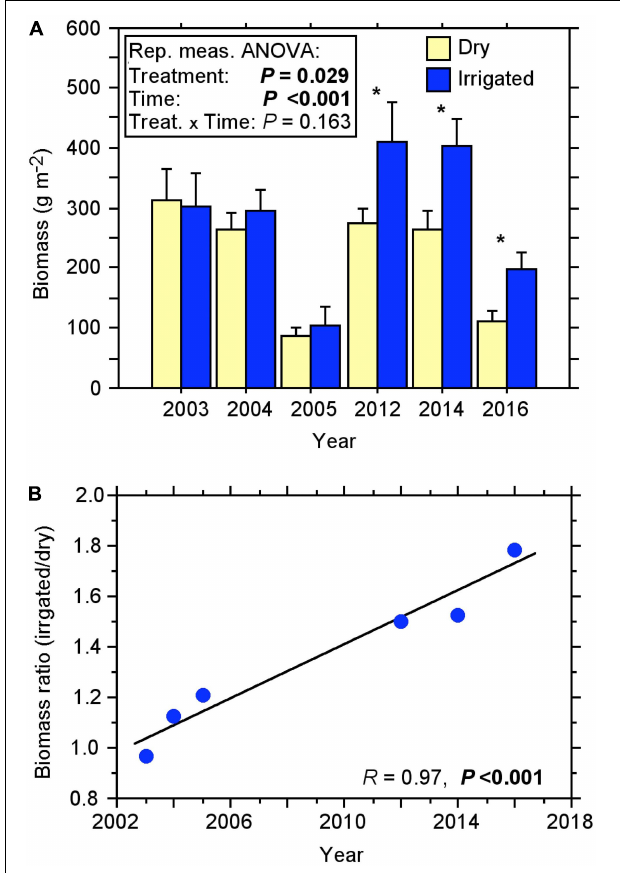
FIGURE 1 | Fine-root biomass of the topsoil (0–10 cm) under dry and irrigated conditions of the Scots pine forest for the years 2003 to 2016 recorded by soil coring. (A) Course of biomass ( ± SE). Repeated measures ANOVA, significant effects ( P < 0.05) are shown in bold; One-way ANOVA, significant effects ( P < 0.05) are indicated with ∗ . (B) Relationship between the biomass ratio (irrigated/dry) and the sample years, a significant effect ( P < 0.05) is shown in